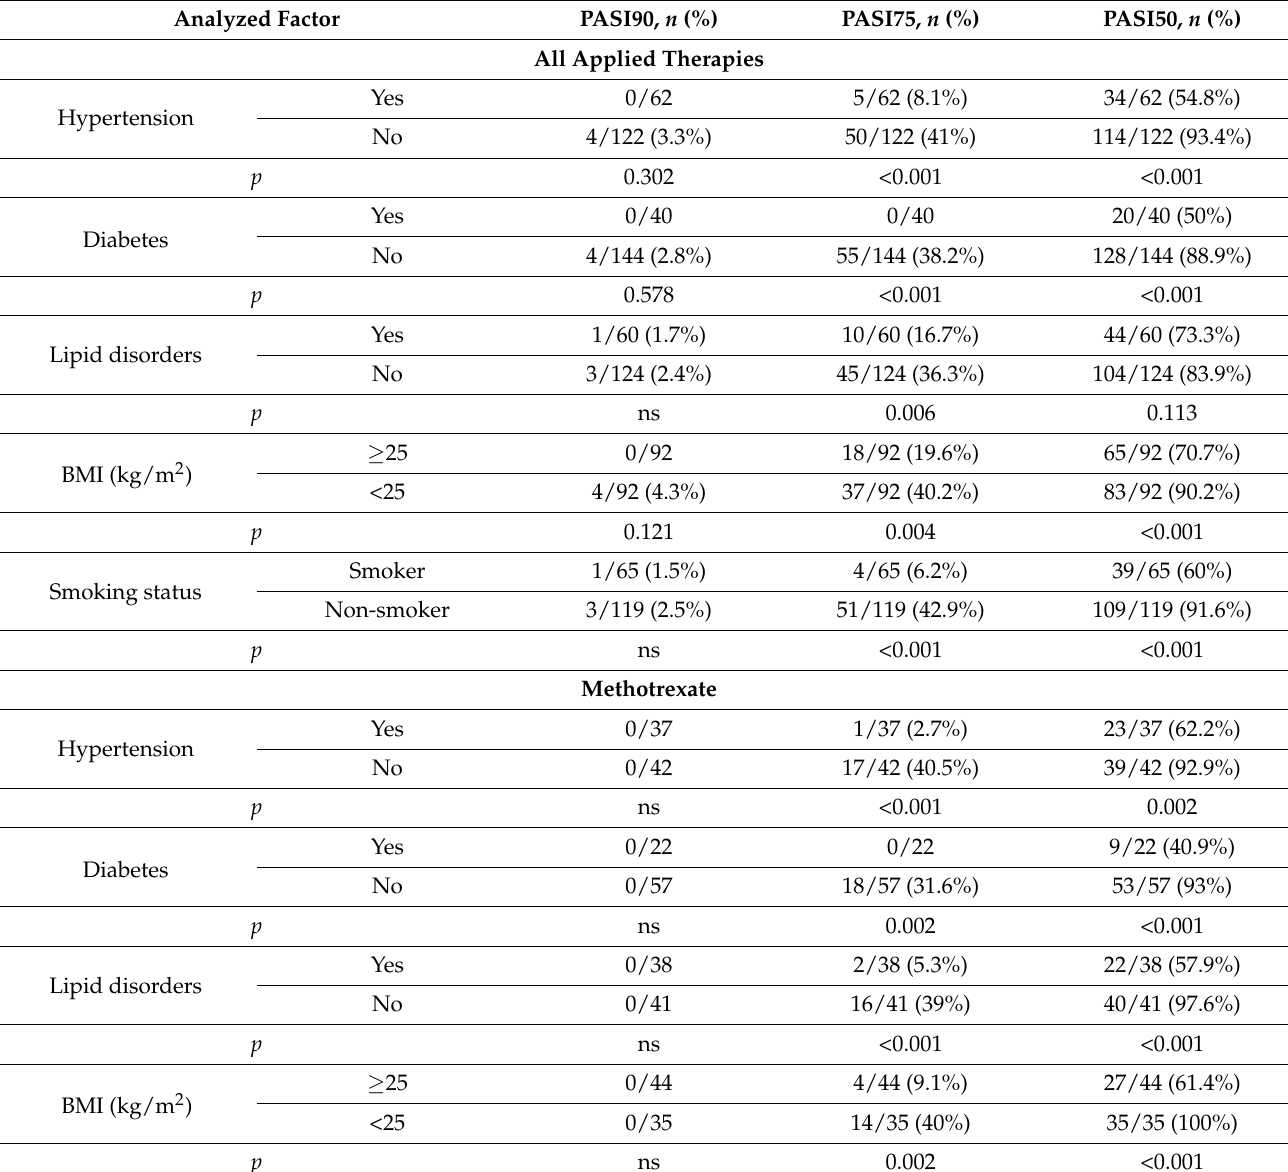
Table 4. The number and percentage of psoriatic patients achieving 90%, 75% and 50% improvement in PASI score after a 3-month treatment with different therapies depending on the presence of comorbidities, BMI score and smoking status on the presence of comorbidities, BMI score and smoking